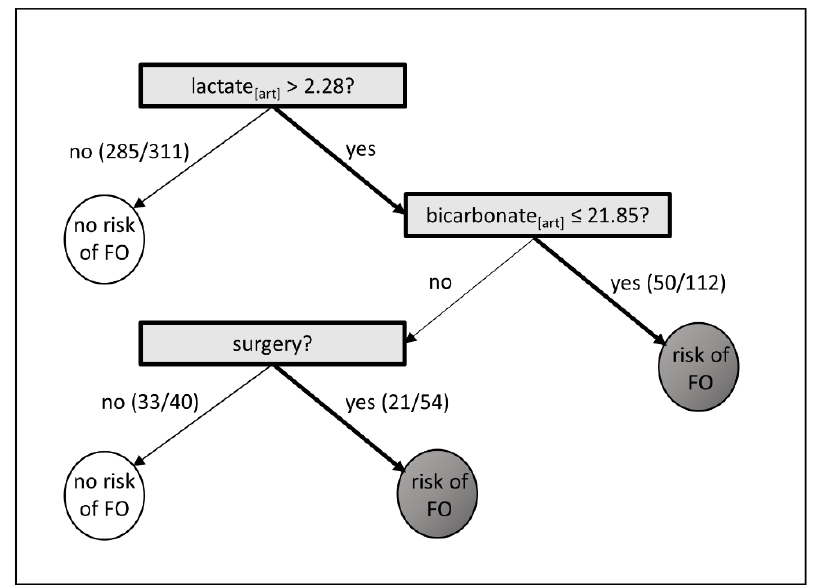
Figure 2. Fast and Frugal Tree. Variables are considered sequentially, with possible stop decision after each question. White circles indicate no risk of fluid overload (FO), and dark grey circle indicate a risk of FO Lactate and bicarbonate were measured in arterial blood samples (art).